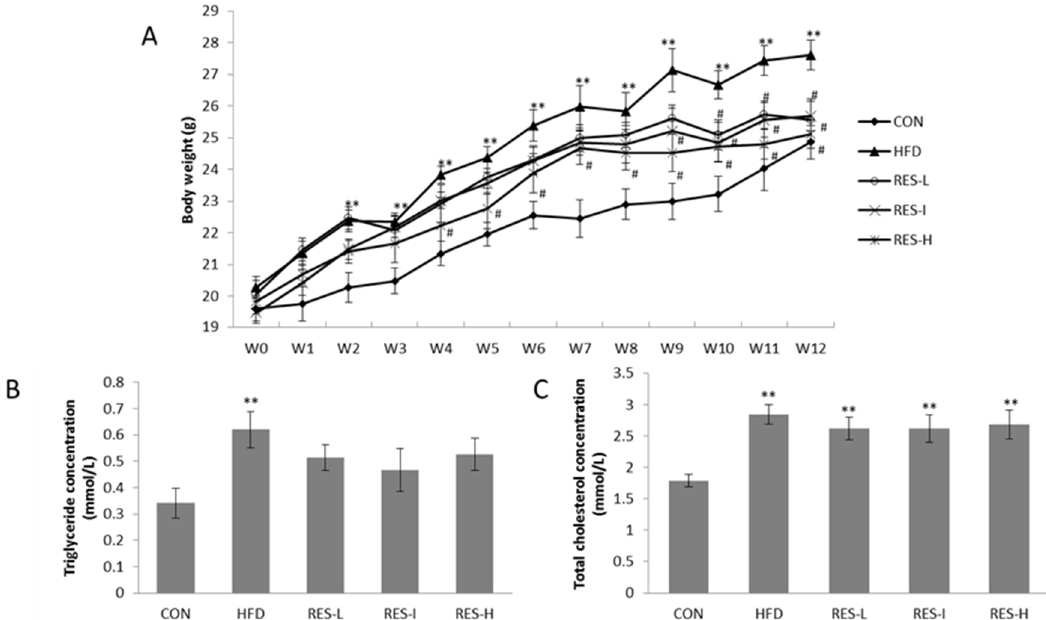
Figure 1. Effect of resveratrol on body weight and serum lipid levels. Male C57BL/6 mice were divided into five groups ( n = 12 per group). Mice in the CON group received a standard diet containing 10% kcal from fat. Mice in the HFD group received a homemade HFD containing 58% kcal from fat. Mice in the RES-L, RES-I, and RES-L groups received a HFD with various doses of resveratrol by oral gavage for 12 weeks. ( A ) Body weights were measured weekly for 12 weeks; serum triglyceride levels ( B ); and serum total cholesterol levels ( C ) were measured after 12 weeks. All data are expressed as the mean ± SE. ANOVA was used to test for statistical significance. ** p < 0.01 versus the CON group; # p < 0.05 versus the HFD group.